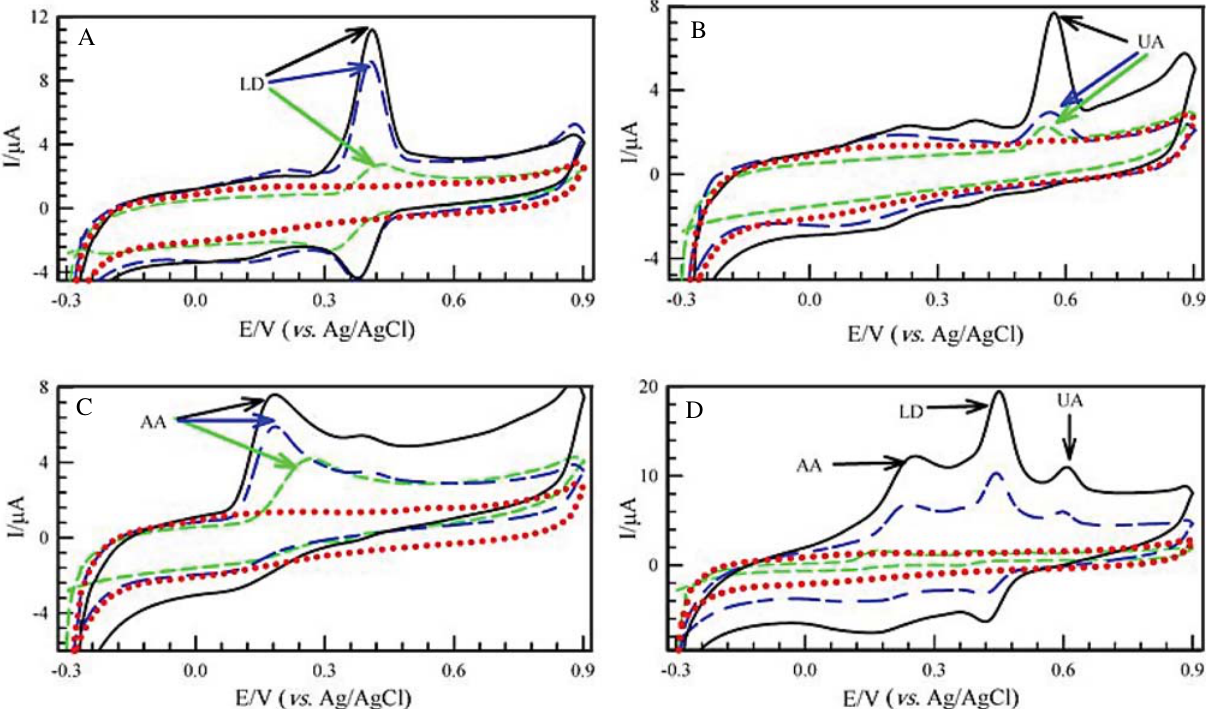
Figure 3. Cyclic voltammograms of blank solution in the absence of any analyte (red dotted lines) and 2 μmol L –1 LD (A), 60 μmol L –1 UA (B), 100 μmol L –1 AA (C) and the mixture of the three analytes (D) obtained on the surface of bare GC (green short dashed lines), modified PDB/GC (blue long dashed lines), and PDB/MWCNTs-GC electrodes (solid black lines). The potential scan rate was 0.100 V s –1 and supporting electrolyte was 0.11 mol L –1 PBS, pH